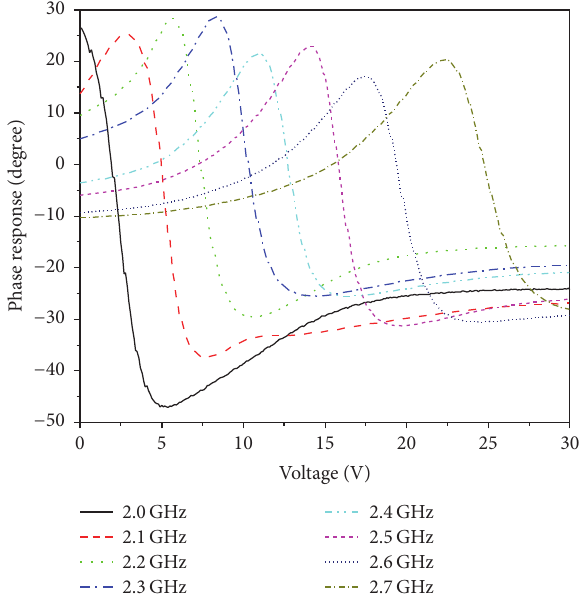
Figure 7: Measured phase response for different